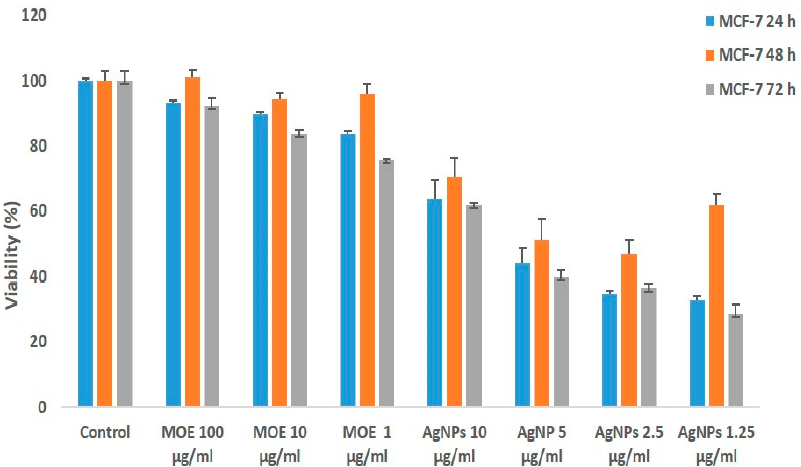
Figure 4. Cytotoxic effect of biosynthesized silver AgNPs and M. oleifera extract (MOE) on cell viability of MCF-7. Cells were treated at various concentrations of AgNPs and MOE for 24, 48 and 72 h, and cytotoxicity was determined by MTT. Results are expressed as the mean ± standard deviation of three independent experiments.